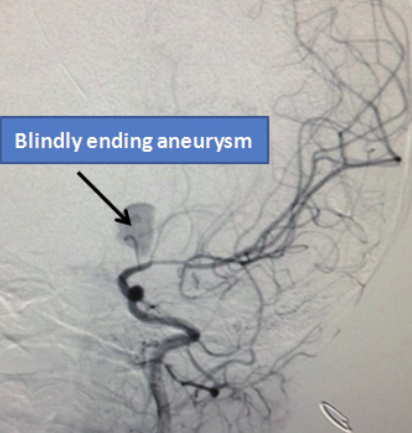
Figure 3. Diagnostic angiography showing the presence of blind left A1